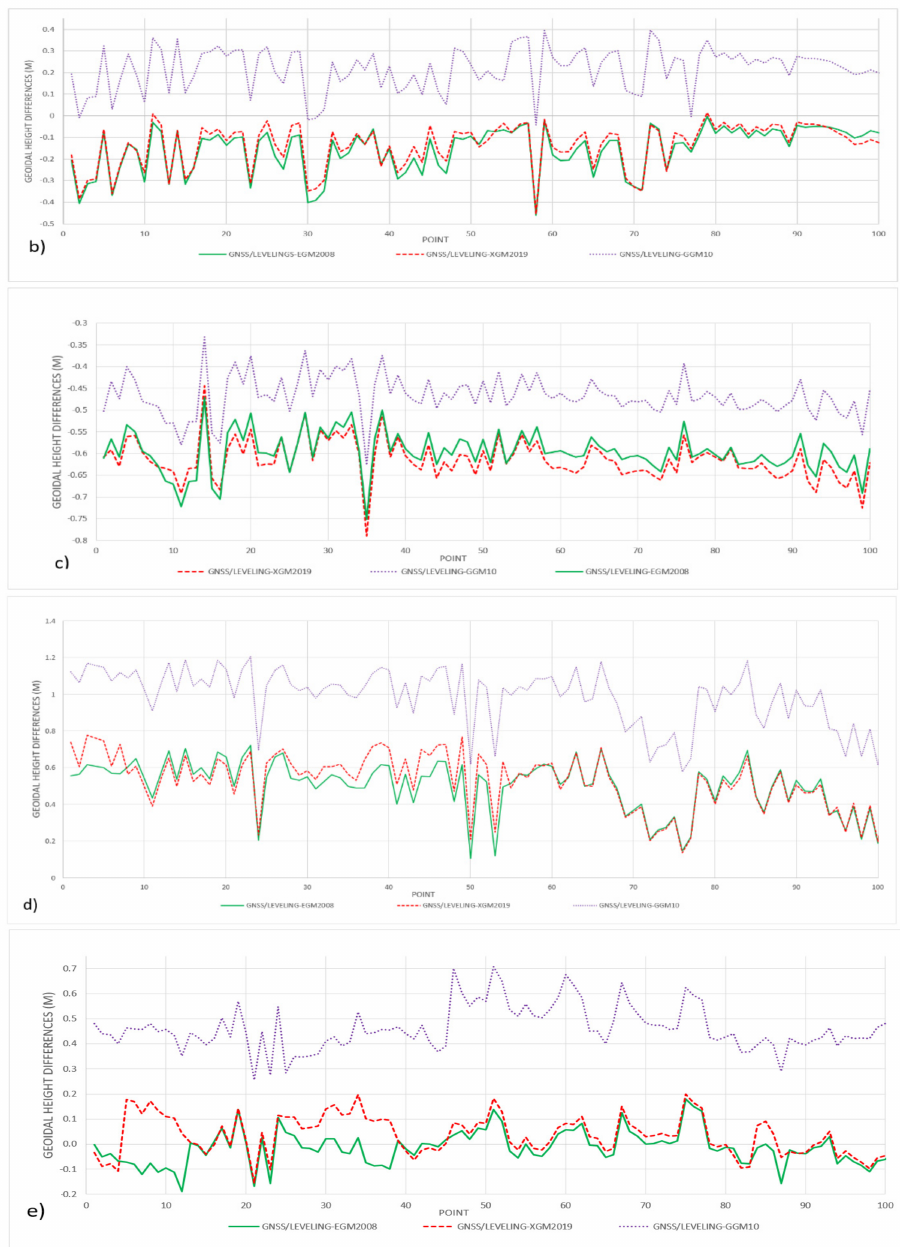
Figure 2. Geoid undulation differences between the geoid models: EGM2008, XGM2019e_2159, and GGM10, and GNSS/leveling stations for five Mexican urban areas: ( a ) Durango, ( b ) Hermosillo, ( c ) Merida, ( d ) Mexico City, ( e ) Monterrey. Units: